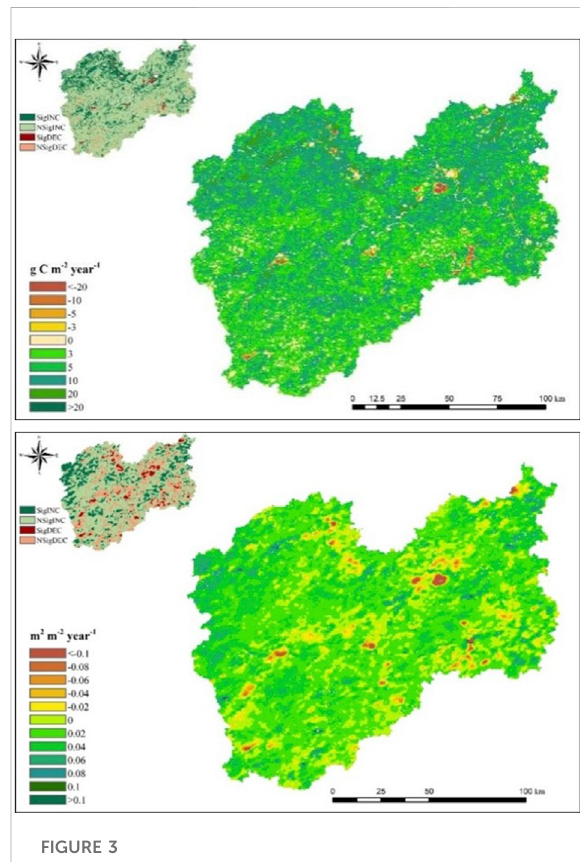
FIGURE 3 Change rate of NPP and Lai (SigINC, signi fi cantly increased; NSigINC, increased but not signi fi cantly; SigDEC, signi fi cantly decreased; NSigDEC decreased but not signi fi